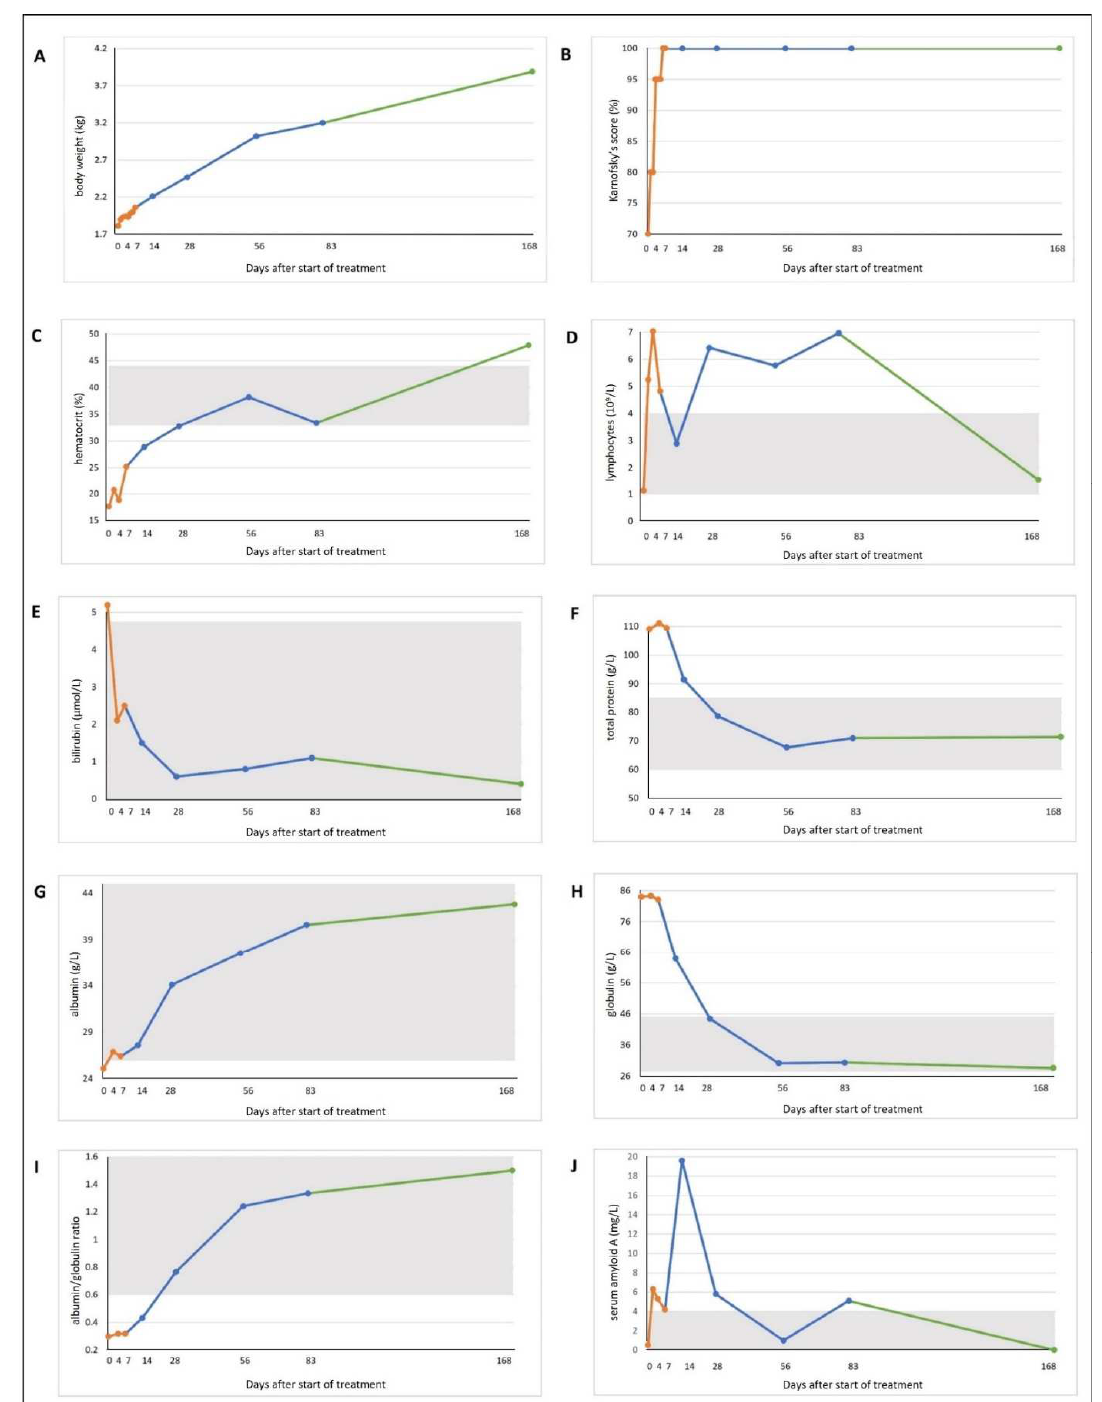
Figure 2. Timeline visualizing improvement of clinical and laboratory parameters throughout the study course. Lines are colored according to the different study sections: orange, hospitalization (day 0–7); blue, recheck visits during treatment (day 14, 28, 56, 83); green, follow-up period at the end of treatment. Grey shading marks the reference ranges, if present. ( A ) Body weight. ( B ) Karnofsky score modified for cats [10]. ( C ) Hematocrit. ( D ) Lymphocyte count. ( E ) Bilirubin concentration. ( F ) Total protein concentration. ( G ) Albumin concentration. ( H ) Globulin concentration. ( I ) Albumin/globulin ratio. ( J ) Serum amyloid A concentration.